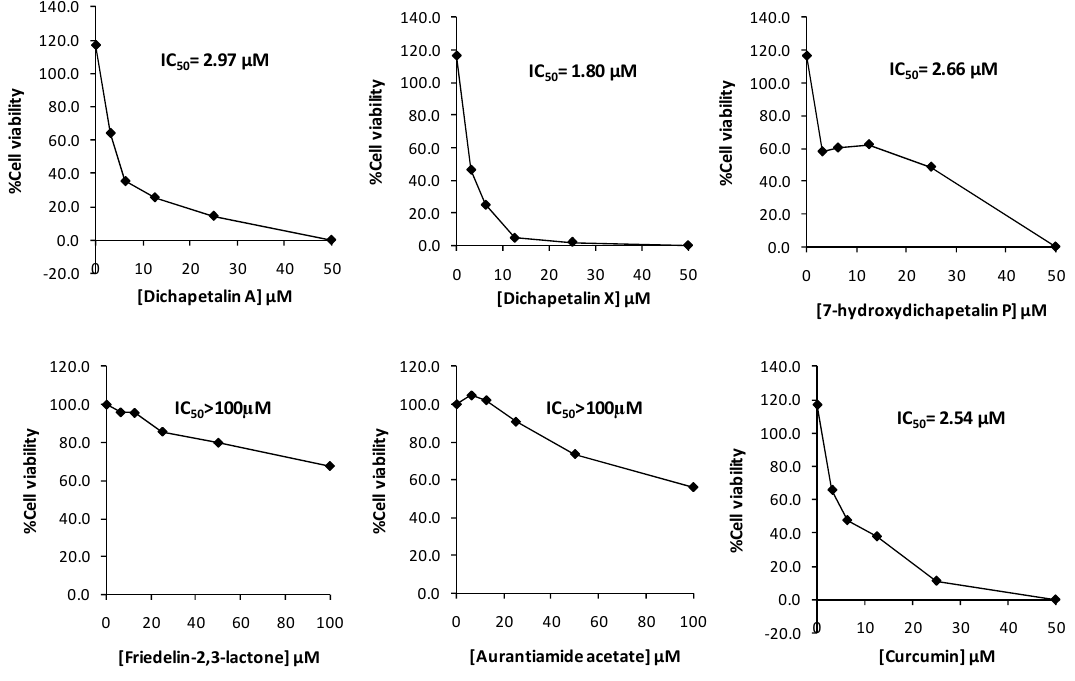
Figure 4. Cytotoxic effect of compounds 1 – 5 and curcumin on Jurkat cell viability.